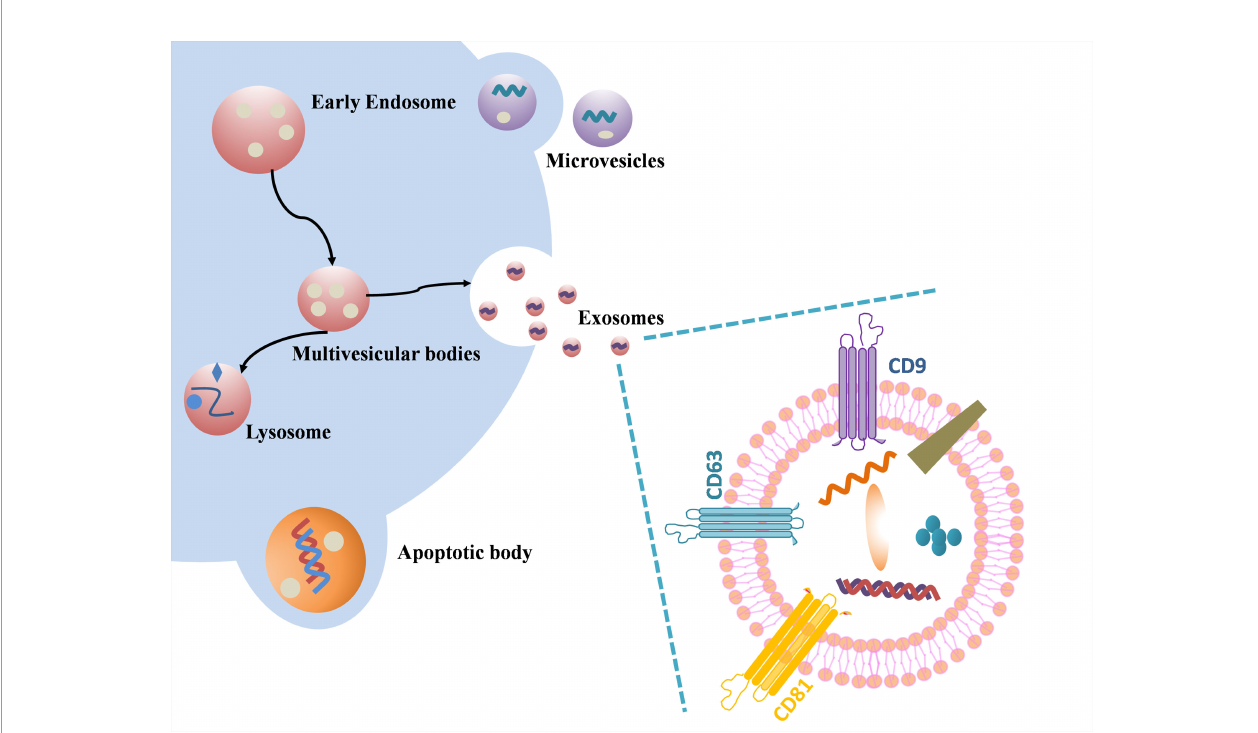
FIGURE 1 | Schematic illustration of exosome biogenesis and component. Differently from microvesicular bodies (MVBs) and apoptotic bodies, exosome derive from the endosomal pathway by evolution of the early and then late endosomes, and ultimately MVBs fuse with plasma membrane to release the exosomes. Exosome surface proteins include characteristic markers (CD9, CD81, CD63 and so on). Exosomes encapsulate various sorts of cell surface and intracellular proteins, coding and non-coding RNAs, DNA, amino acids, and some